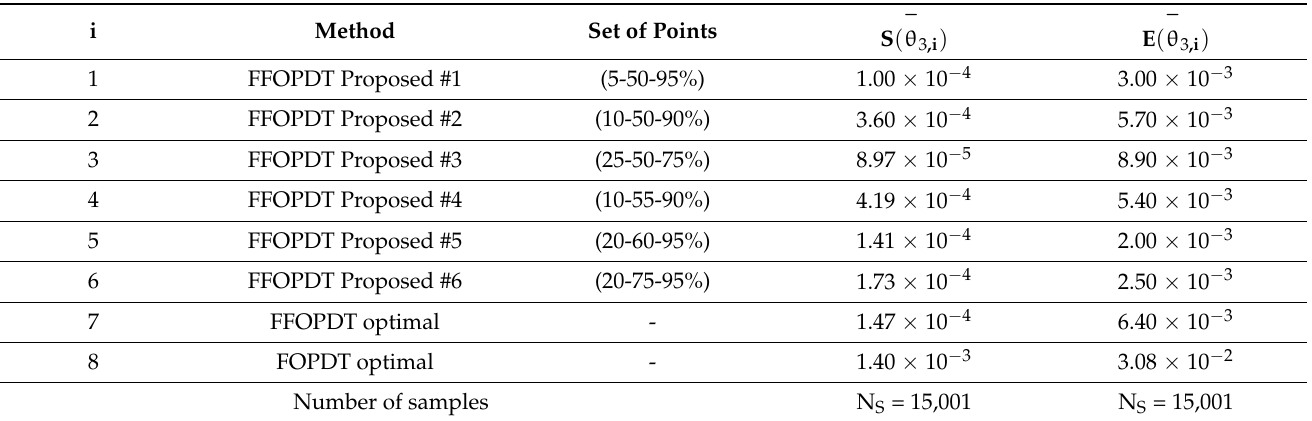
Table 22. Comparison between the performance indexes obtained for the proposed method with different sets of points, symmetrical and asymmetrical, and the ones for optimal methods for FFOPDT and FOPDT models. The number of samples N S is also